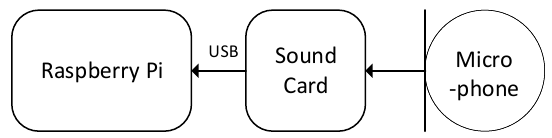
Figure 4. Block diagram of the listener module hardware.